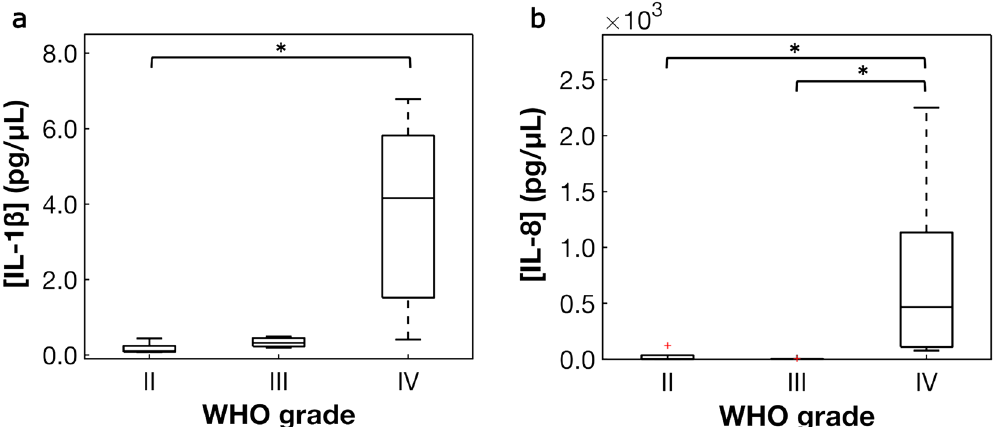
Figure 3. Box plots of inflammatory markers that varied significantly as a function of WHO grade. Inflammatory markers in glioma samples were quantified using electrochemiluminescence assays. Differences as a function of WHO grade were assessed with Kruskal–Wallis H-tests and post-hoc pair-wise Dunn’s tests (Table 3). A Bonferroni correction was applied to the p value of the Dunn’s test to correct for multiple comparisons within each inflammatory marker. Significant differences were observed for ( a ) IL-1β, and ( b ) IL-8. *Denotes significance at p ≤